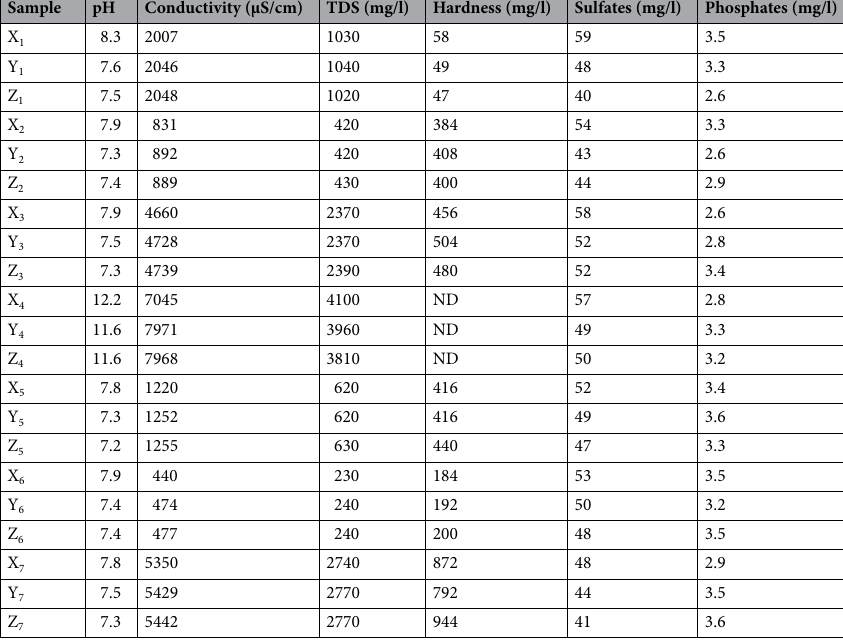
Table 4. Water quality parameters of untreated, plasma treated and plasma/catalyst treated water